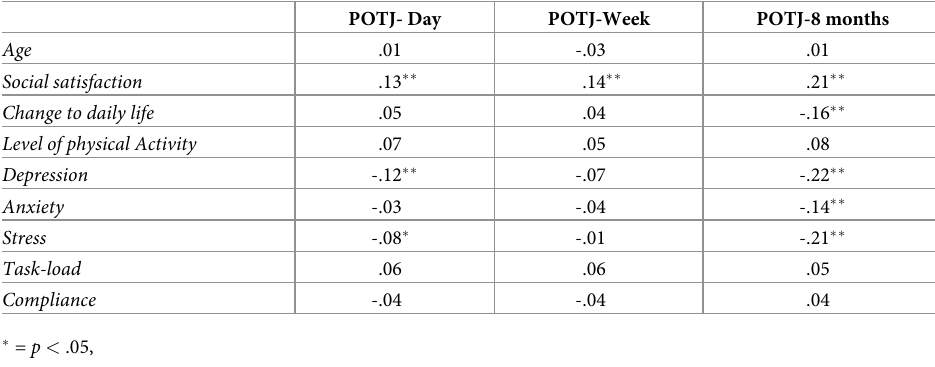
Table 3. Correlation coefficients between POTJs, age, measures of affect, load, compliance and change to